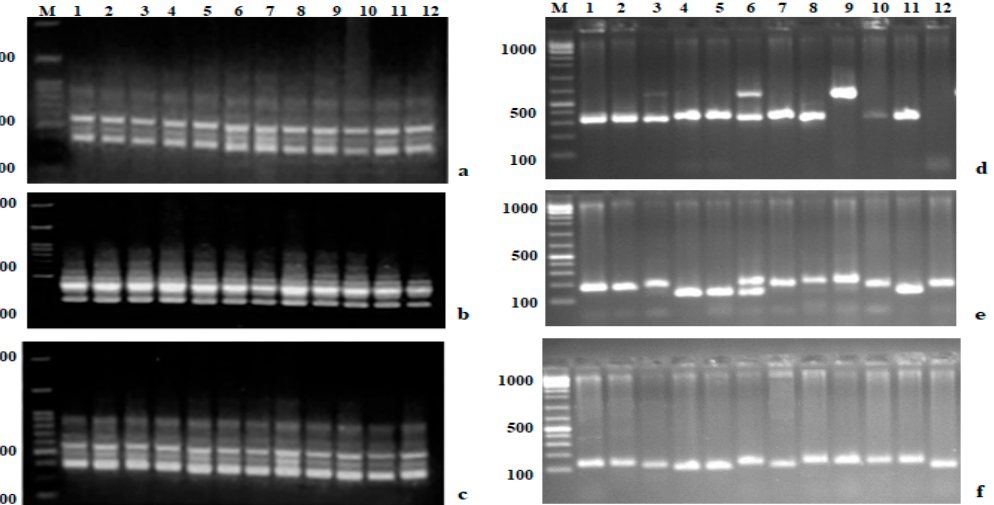
Figure 2. Samples of ISSR (left panel) and SSR (left panel) banding patterns obtained from 12 rice genotypes with primers HB15 ( a ), 49A ( b ), 44B ( c ), RM224 ( d ), RM211 ( e ), RM3873 ( f ). M is 100 bp DNA marker, and numbers 1 to 12 are rice genotypes.